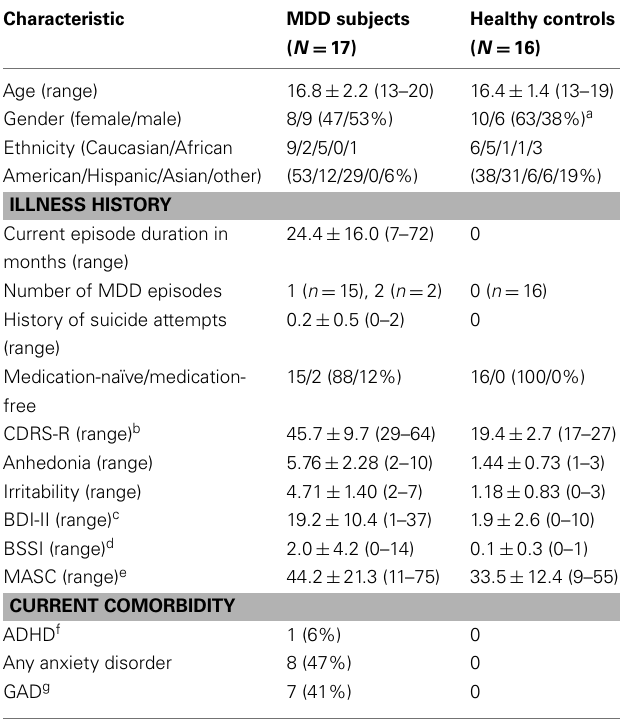
Table 1 | Demographic and clinical characteristics of adolescents with major depressive disorder (MDD) and healthy